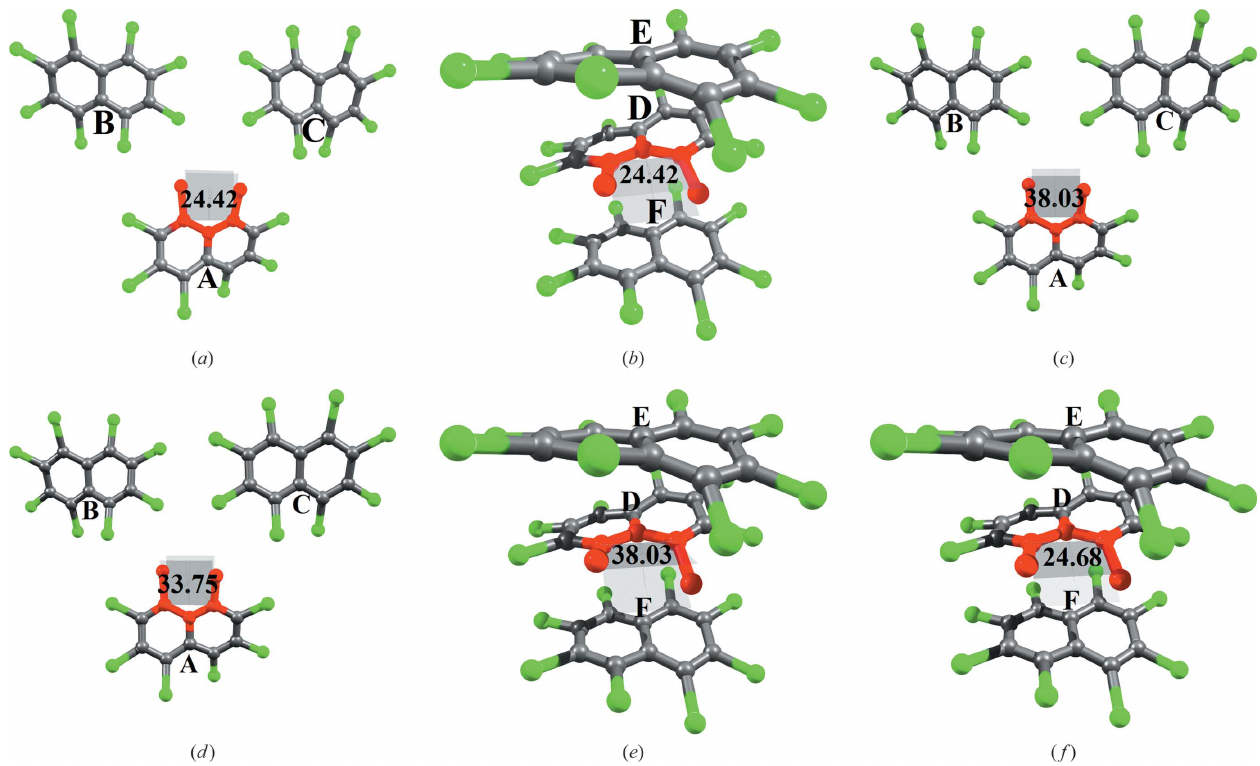
Figure 13 ( a )–( b ) Molecular conformations from crystal geometry T 1 (cid:5) and T 2 (cid:5) . ( c )–( d ) Molecular conformations showing the value of (cid:6) 2 in a starting geometry ( T 1) and optimized geometry ( T 1 0 ). ( e )–( f ) Molecular conformations showing the value of (cid:6) 2 in the starting geometry ( T 2) and optimized geometry ( T 2 0 Sarkar and Row (cid:3) Peri versus intermolecular interactions in naphthalene